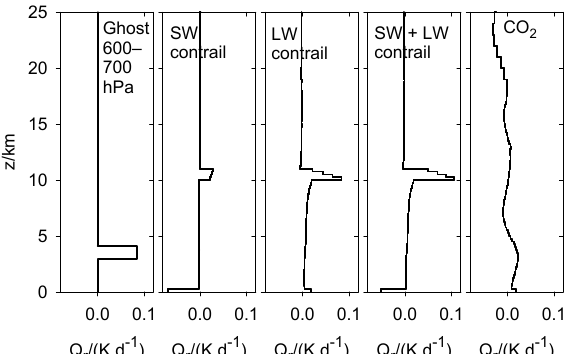
Figure 5. Initial and final radiative flux changes (cid:49)F versus height z as induced by a disturbance from added ghost heating, SW, LW, and SW + LW contrail cirrus, and 10% increased CO 2 , in the pan- els from left to right. Black full lines (i): instantaneous flux; red dashed line (s): adjusted to constant surface temperature; blue dash- dotted line (e): equilibrium over adiabatic surface. The fluxes, F , are positive if upwards.